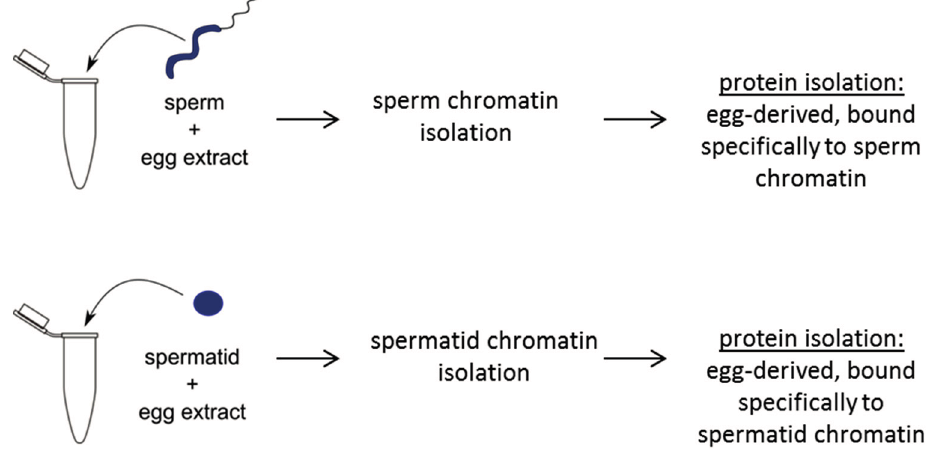
Figure 4. Schematic diagram showing experimental design for mass spectrometry analysis of extract-treated sperm or spermatids. Sperm or spermatids are separately treated with egg extracts. Subsequently, sperm or spermatid chromatin is purified and chromatin-bound proteins are isolated. Isolated proteins are then subjected to 2D-DIGE and mass spectrometry